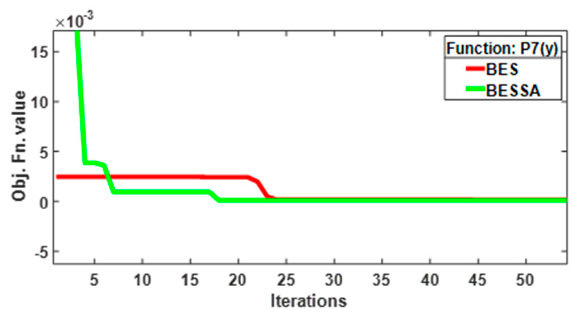
Figure 3. Convergence profile for function p 7 .